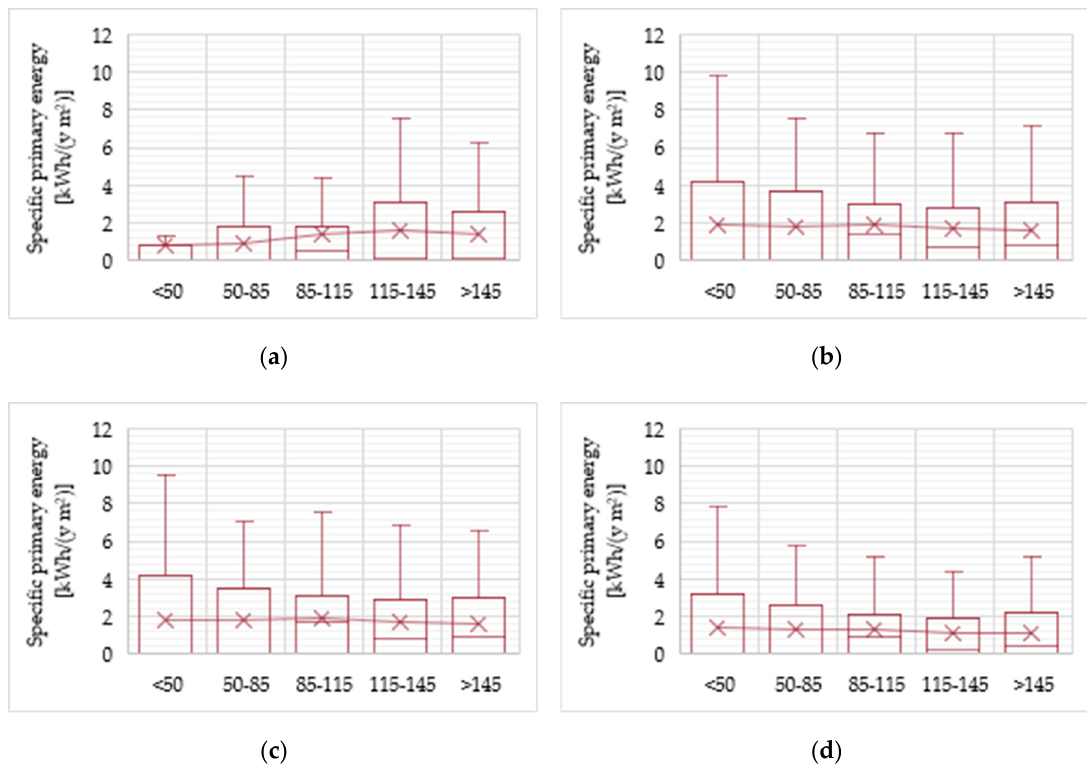
Figure 7. Specific consumption of primary energy for cooling—Scenario #0. ( a ) Milan; ( b ) Florence;